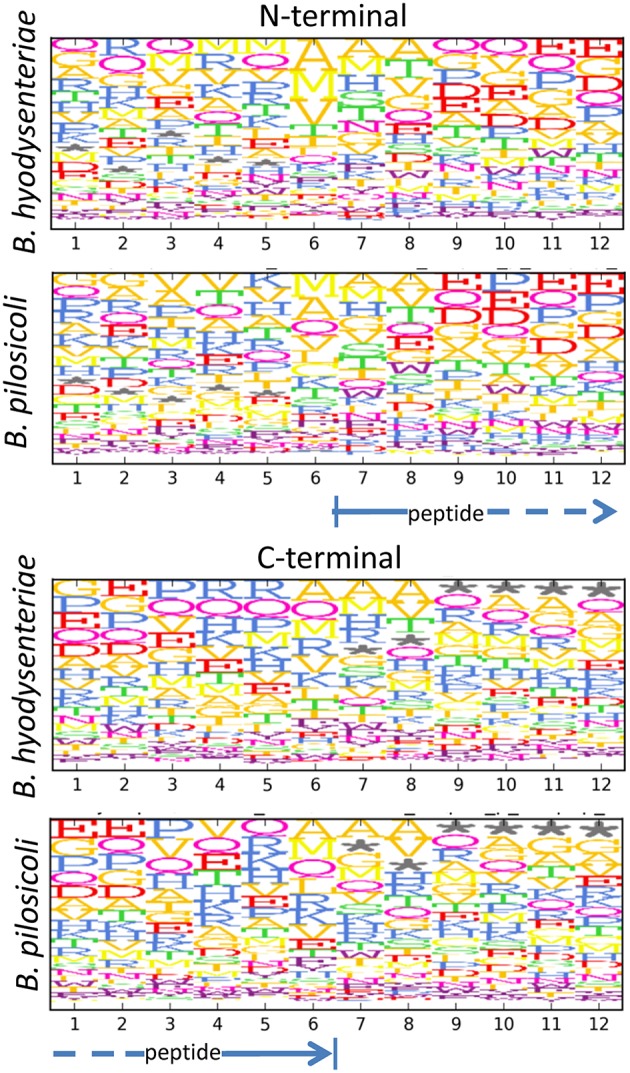
Motifs in the N- and C-terminal regions of peptides in the exopeptidome fraction. Size and top to bottom position of the amino acid letters are related with the frequency at which the amino acid is observed on that position. Frequencies are corrected for the amino acid frequency in the full Brachyspira database. An asterisk denotes the absence of an amino acid (off-sequence positions in protein terminal peptides).